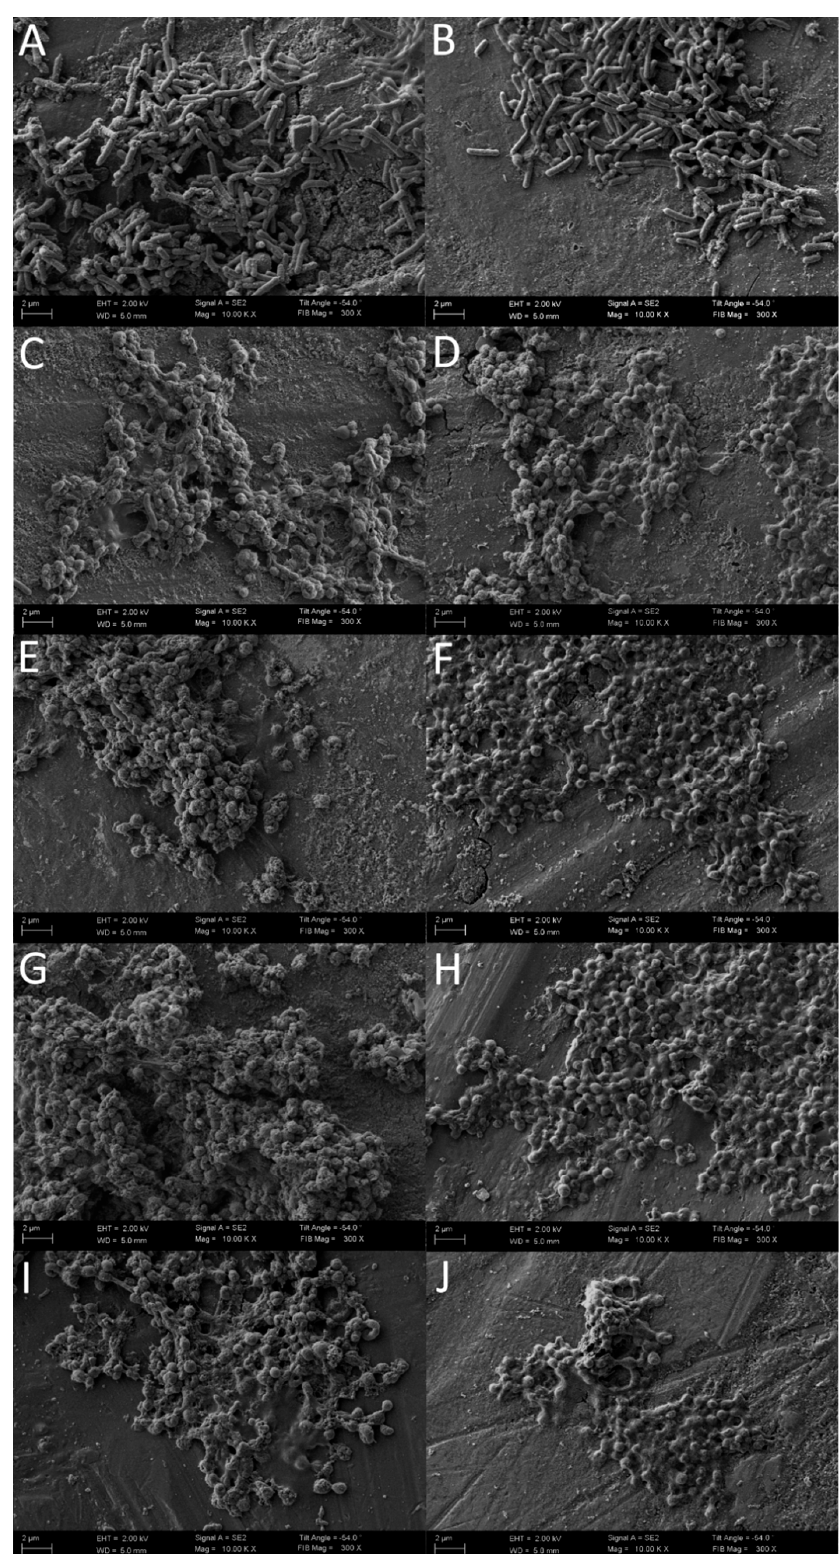
Figure 4. The scanning electron microscopy images of H. pylori Tx30a ( A , C , E , G , and I ) and J99 ( B , D , F , H , and J ) cells ( A , B ) without 3-Bromopyruvate (3-BP), seen mainly as spiral forms, and treated with different concentrations of 3-BP: ( C , D ) ½× MIC, ( E , F ) MIC, ( G , H ) 2× MIC, and ( I , J ) 4× MIC, in which the coccoid forms predominate.